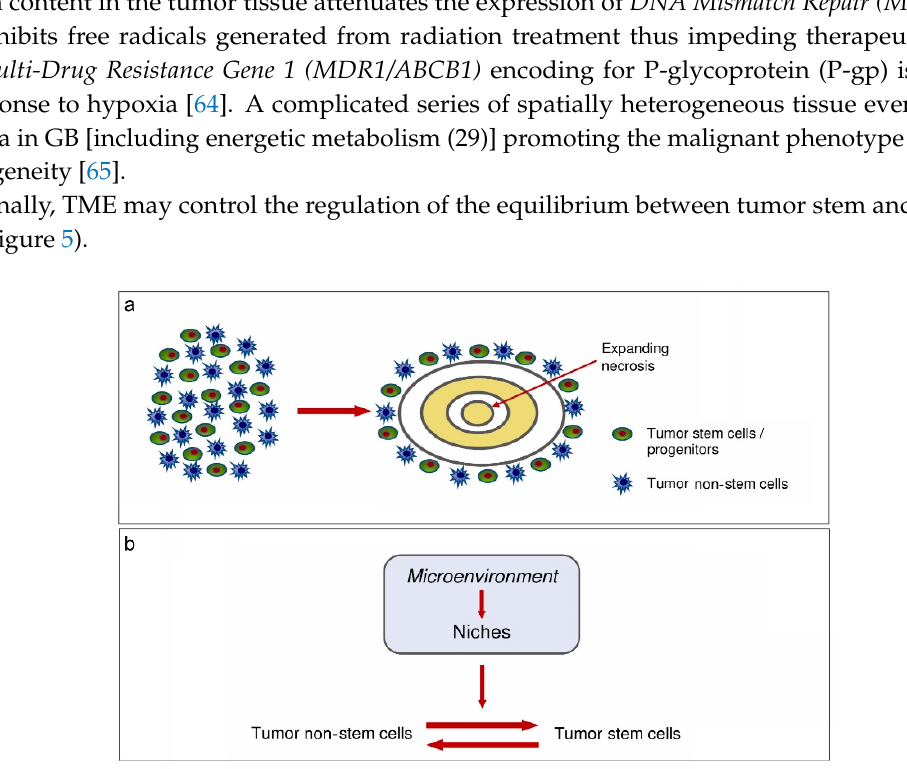
Figure 5. ( a ) Development of circumscribed necrosis. ( b ) Equilibrium between tumor non-stem cells and tumor stem cells [66].